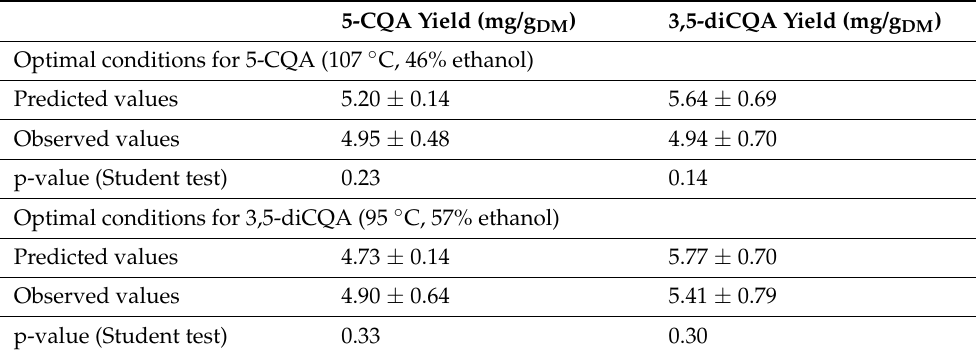
Table 5. Comparison between predicted and experimental values for CQAs